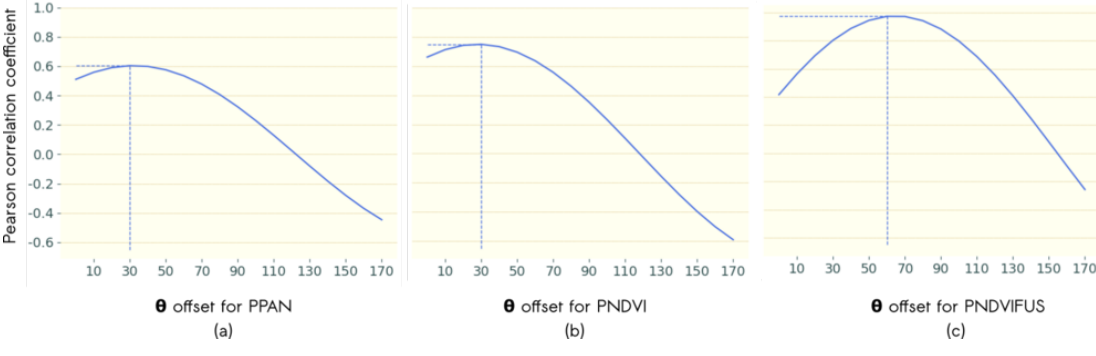
Figure 6. Influence of loadings rotation on correlation of PC1 derived from ( a ) ANDVI with θ = 30 ◦ and PPAN with θ ∈ [ 0 ◦ ,170 ◦ ] ( b ) ANDVI ( θ = 30 ◦ ) and PNDVI with θ ∈ [ 0 ◦ ,170 ◦ ] and (c) PNDVI ( θ = 30 ◦ ) and PNDVIFUS with θ ∈ [ 0 ◦ ,170 ◦ ] . The best correlation values are indicated in blue dotted lines.